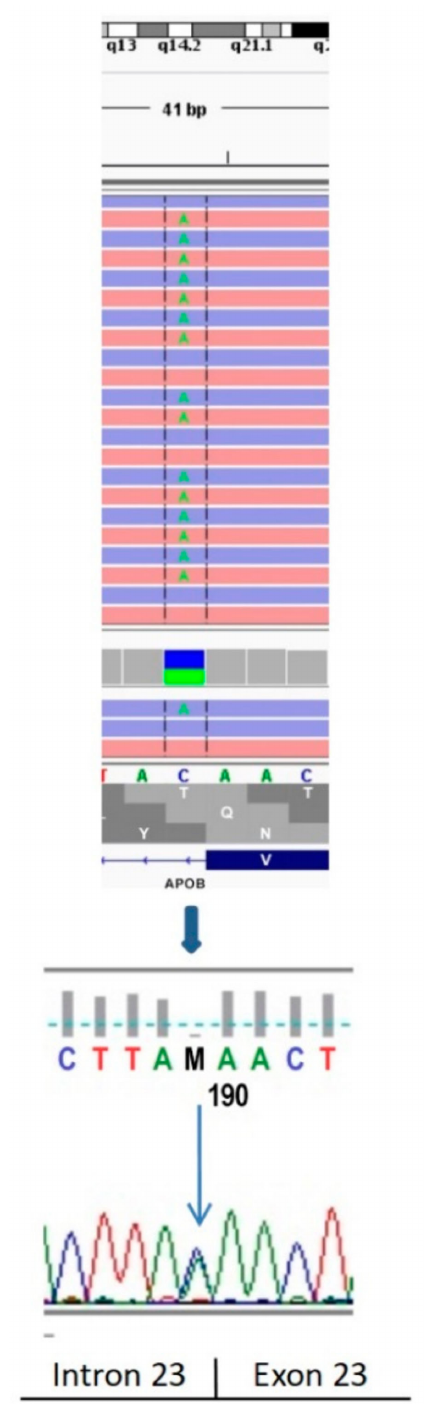
Figure 4. Next-generation sequencing (NGS)-based identification and Sanger sequencing confirmation of the c.3696 + 1G > T